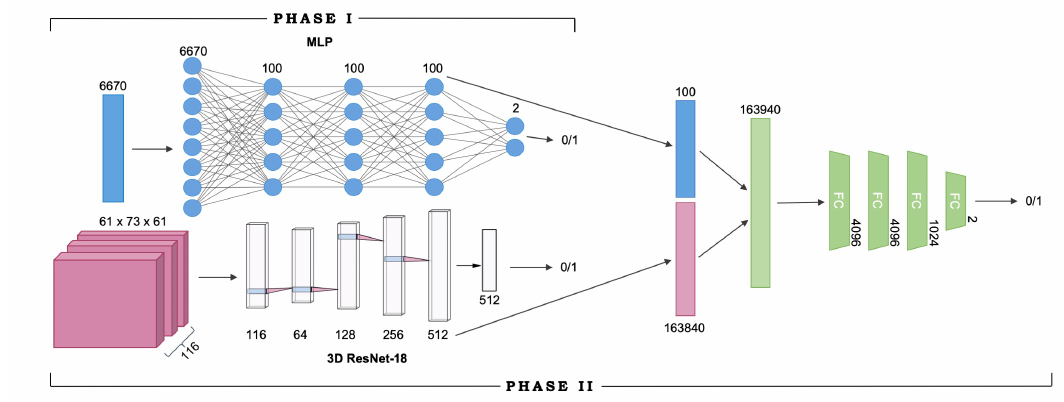
Figure 2. Multimodal network architectures and training phases. Visualization of the structure of the complete deep multimodal network. Numbers denote nodes or input channels in the labeled layer; FC implies fully connected layers. Phase I of training refers to the training of Resnet-18 and MLP for feature extraction; Phase II refers to the end-to-end training of the entire multimodal model after removing output layers from the feature extractors (as shown in the figure, the last 2-node layer of the MLP and the 512-channel layer of the ResNet are bypassed during Phase II of